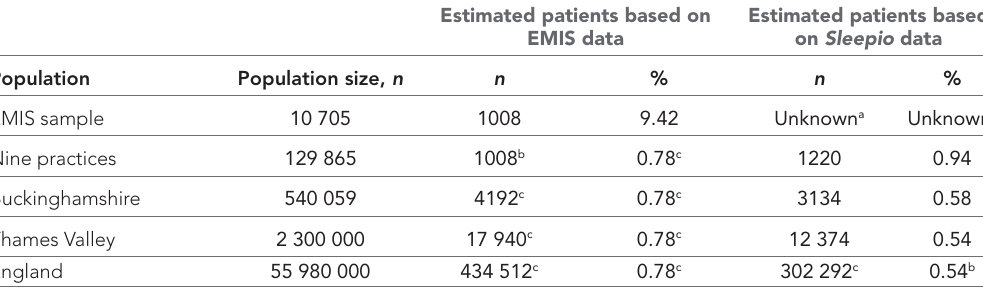
Table 3 Estimated number of patients who used Sleepio by population